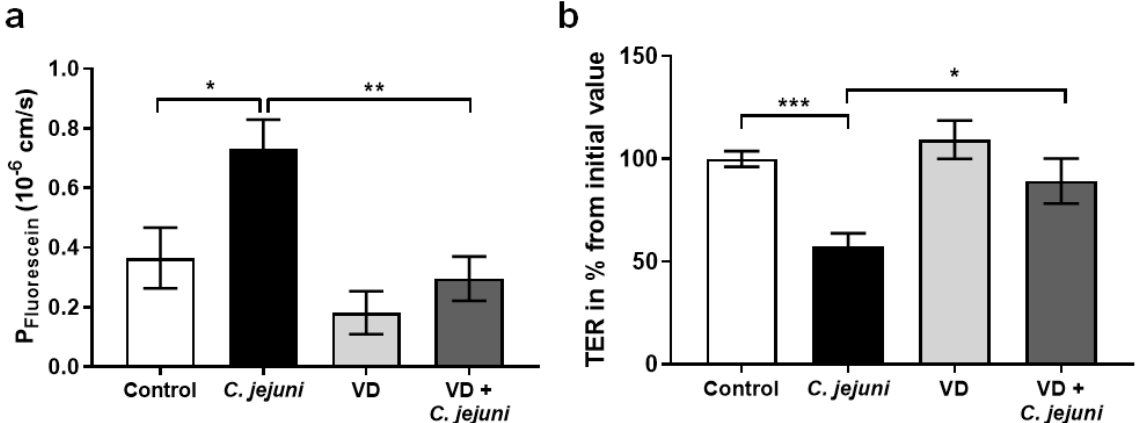
Figure 2. Vitamin D inhibits C. jejuni -induced barrier dysfunction in vitro. HT-29/B6-GR/MR cells grown on filter supports were pre-treated with or without 200 nM vitamin D (VD) from the apical and basolateral sides and infected with C. jejuni from the apical side with a multiplicity of infection (MOI) of 100. After 48 h microaerobic incubation ( a ) 332 Da fluorescein permeability between the apical and basolateral compartments was determined (* p < 0.05, ** p < 0.01, one-way ANOVA with Bonferroni correction, n = 6–7) and ( b ) transepithelial electrical resistance (TER) was measured using chopstick electrodes (* p < 0.05, *** p < 0.001, one-way ANOVA with Bonferroni correction, n = 13–14).